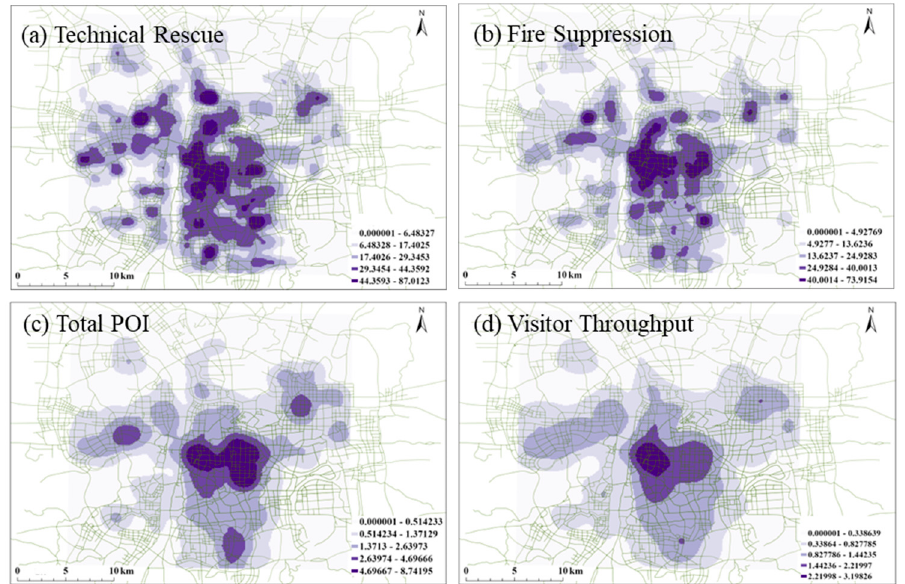
Figure 3. Kernel density distribution maps (natural breakpoint classification).